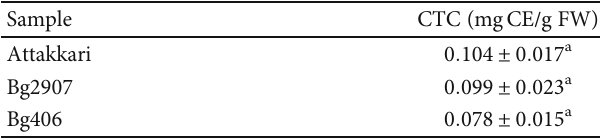
Table 3: The condensed tannin